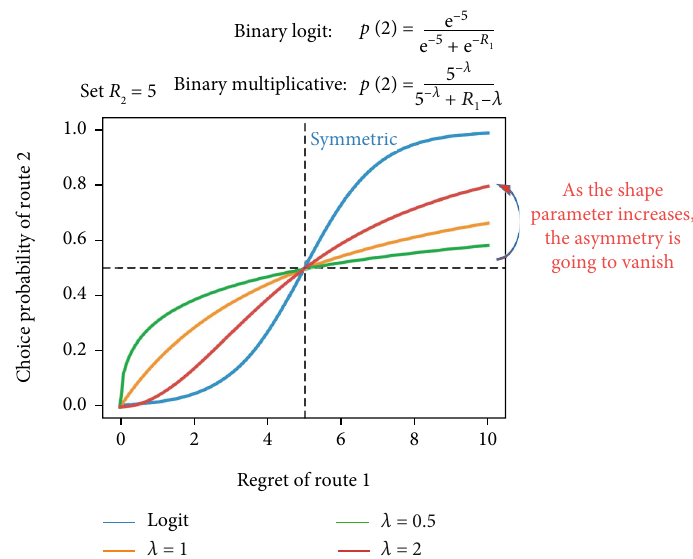
Figure 5: An example to show the symmetric and asymmetric properties of BNL and BNM